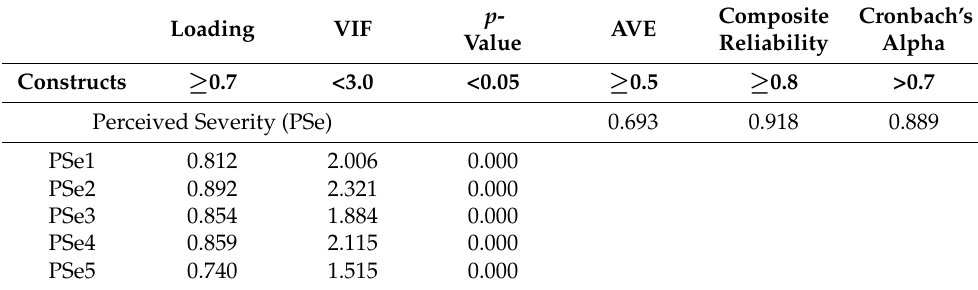
Table 6. Construct validity and reliability for Hypothesis Two .